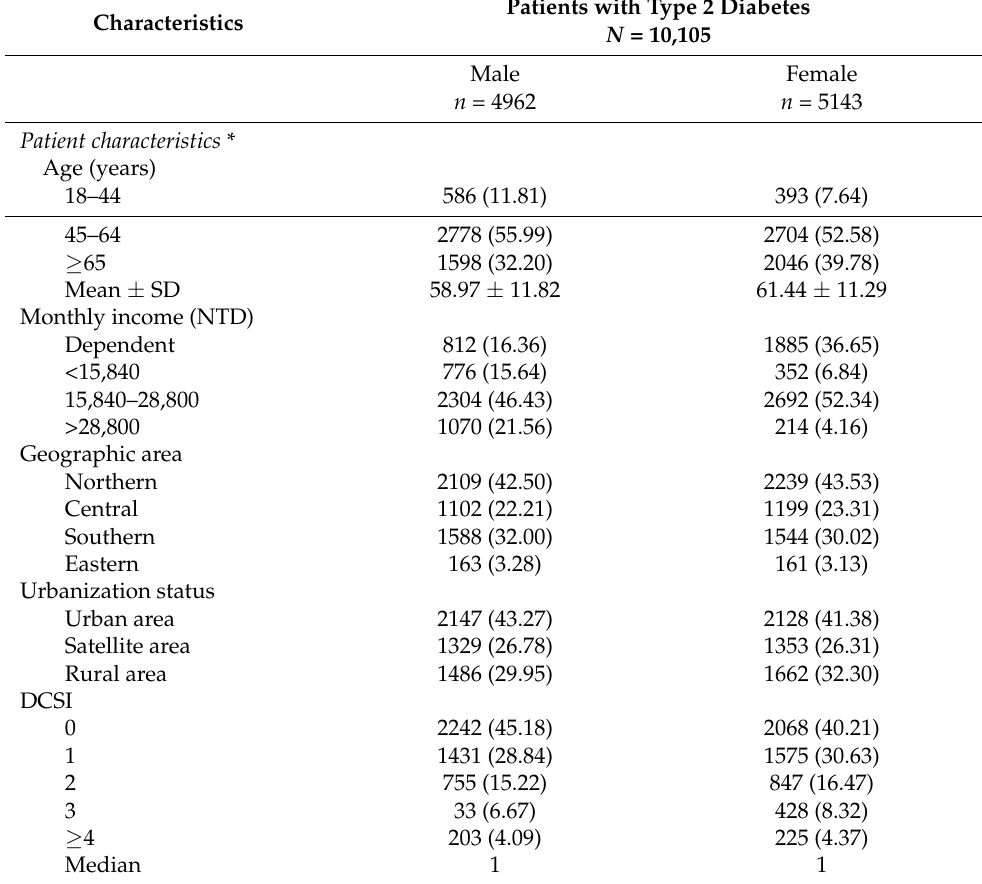
Table 1. Characteristics of type 2 diabetes patients and their